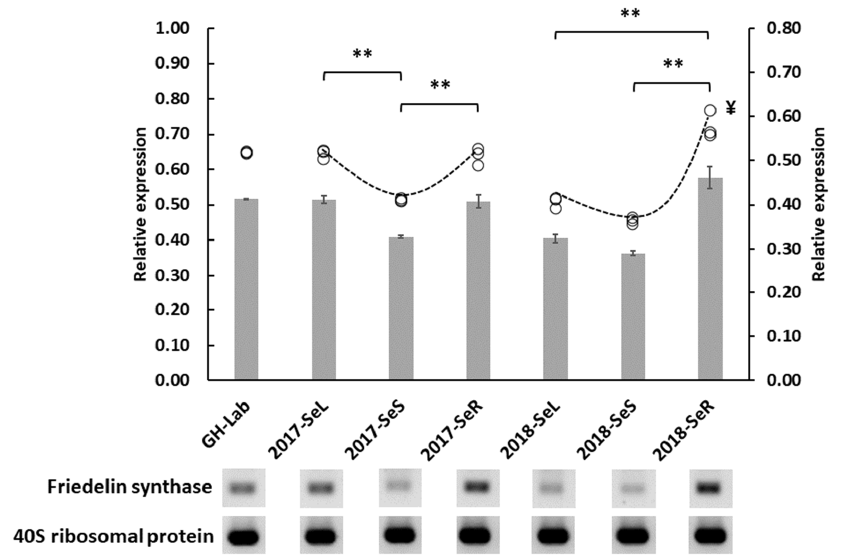
Figure 7. FRS gene expression of G. heterophylla from our laboratory and the 2017 and 2018 collections originating from South Africa. GH-Lab indicates G. heterophylla cultivated in our laboratory, Germany; 2017-SeL, 2017-SeS, and 2017-SeR indicate the leaves, stems, and roots of the 2017 collection of G. heterophylla originating from South Africa; 2018-SeL, 2018-SeS, and 2018-SeR indicate the counterparts from the 2018 collection. Additionally, 40S ribosomal protein is used as a housekeeping gene. The bar graph uses the x -axis on the right side while O indicates each sample data point, using the x -axis of the left side. ** indicates the statistic significantly by one-way ANOVA with p -value ≤ 0.05. ¥ indicates the highest FRS gene expression level.